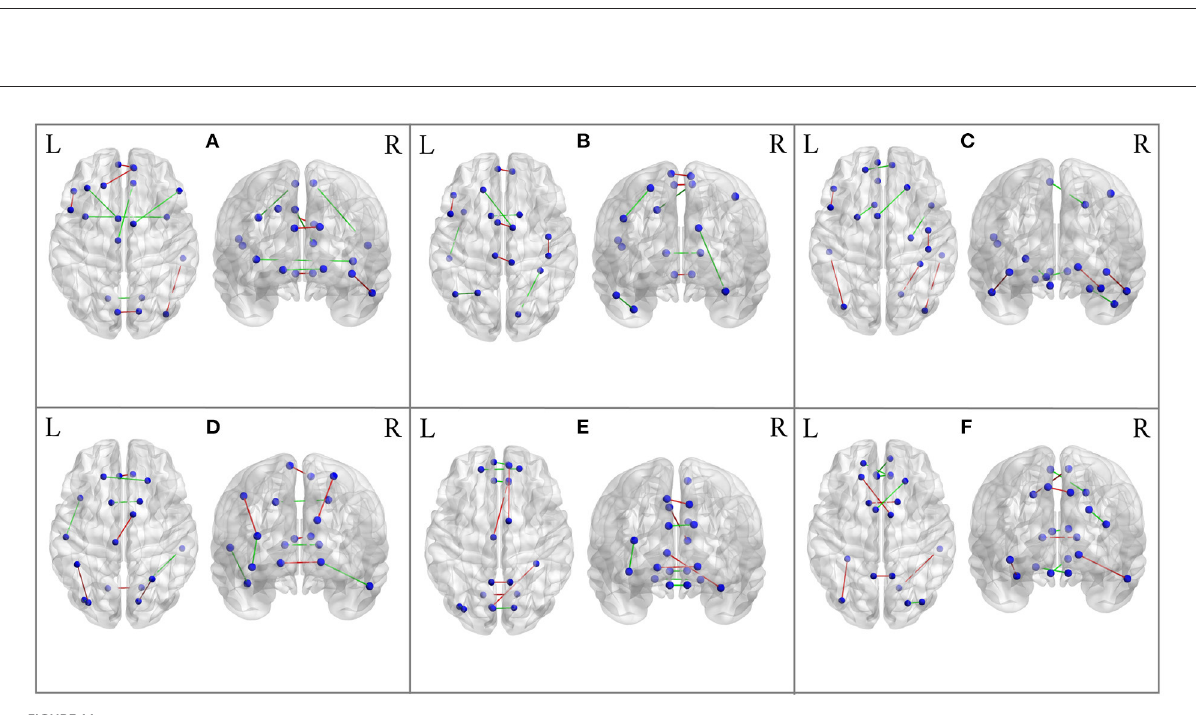
FIGURE11 The most significant 5 reduced connections and 5 increased connections mapped on the AAL 90 template using the BrainNet Viewer software package. Blue color means the ROIs, red color means reduced connections, and green color means increased connections. (A) From NC to SMC. (B) From NC to EMCI. (C) From NC to LMCI. (D) From SMC to EMCI. (E) From SMC to LMCI. (F) From EMCI to